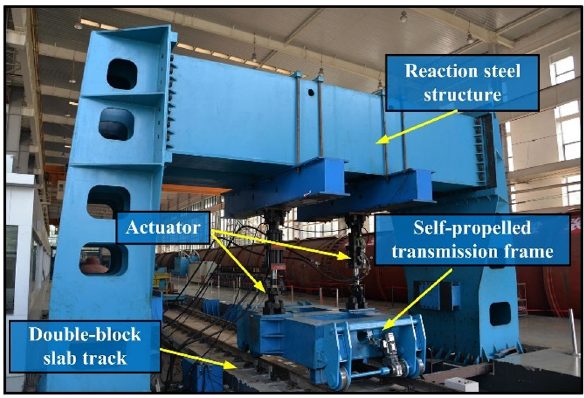
Fig. 19 Dynamic performance evolution test of double-block bal- lastless